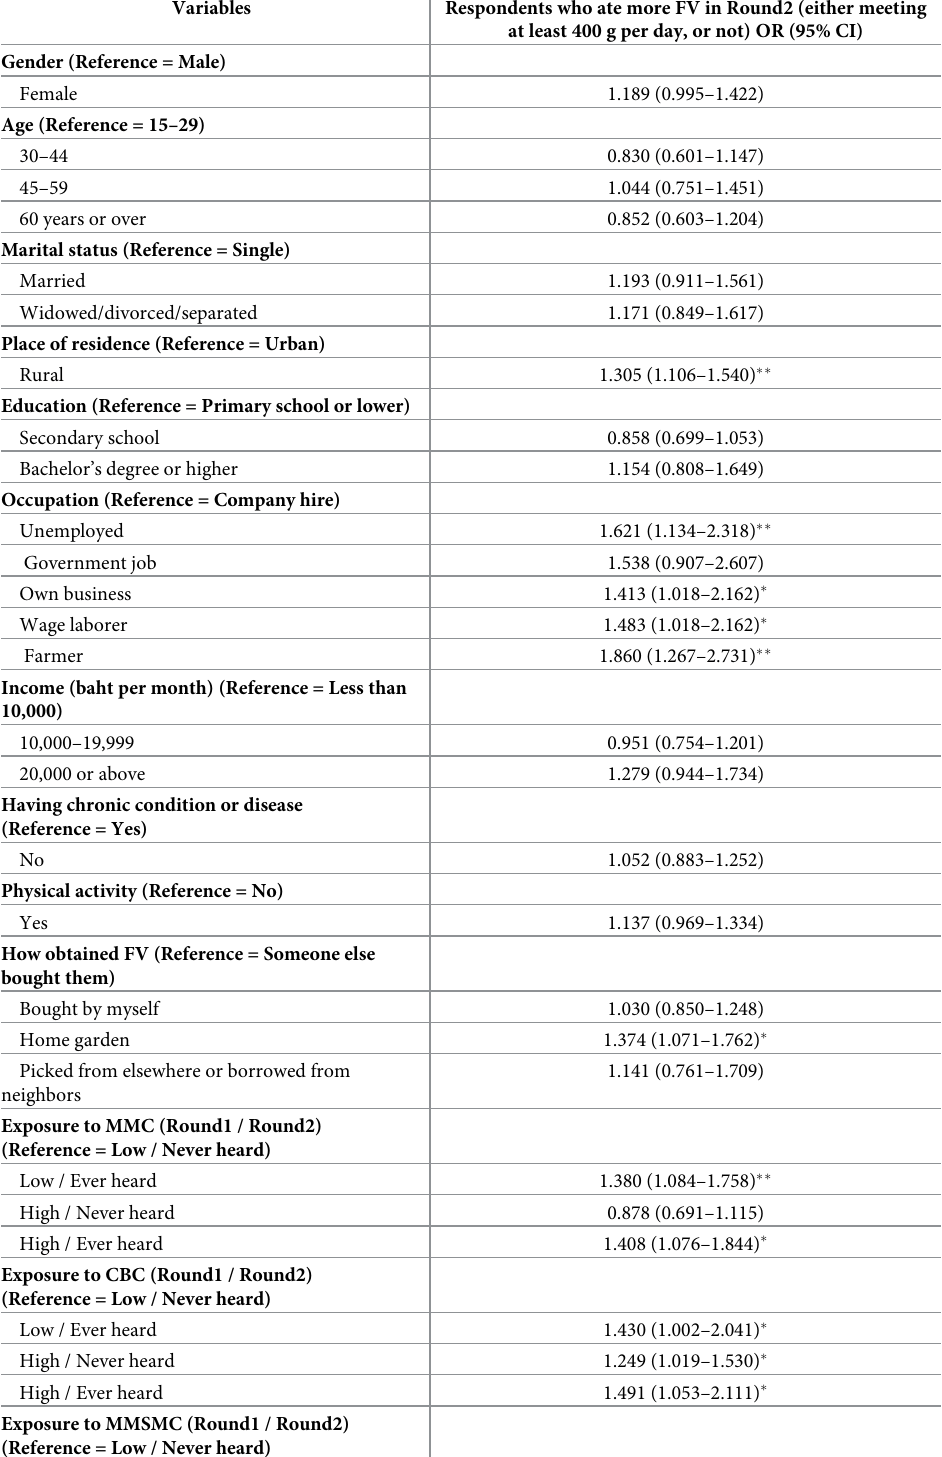
Table 4. Binary logistic regression of implementation of FV campaigns and other factors affecting increases in FV consumption (Model 1).